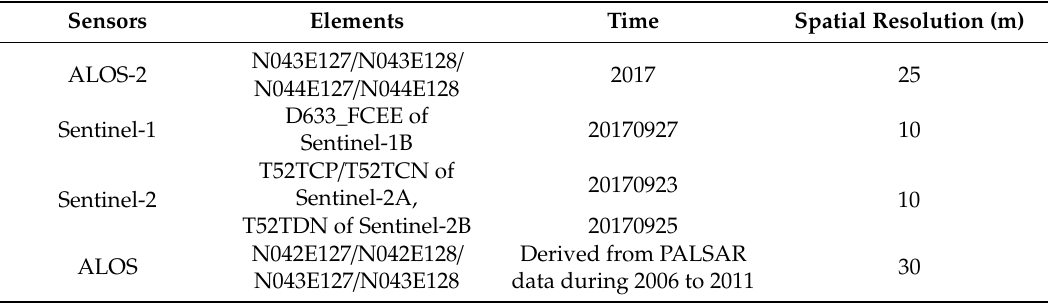
Table 1. The adopted ALOS-2, Sentinel-1, Sentinel-2, and digital surface model (DSM) data. Sensors